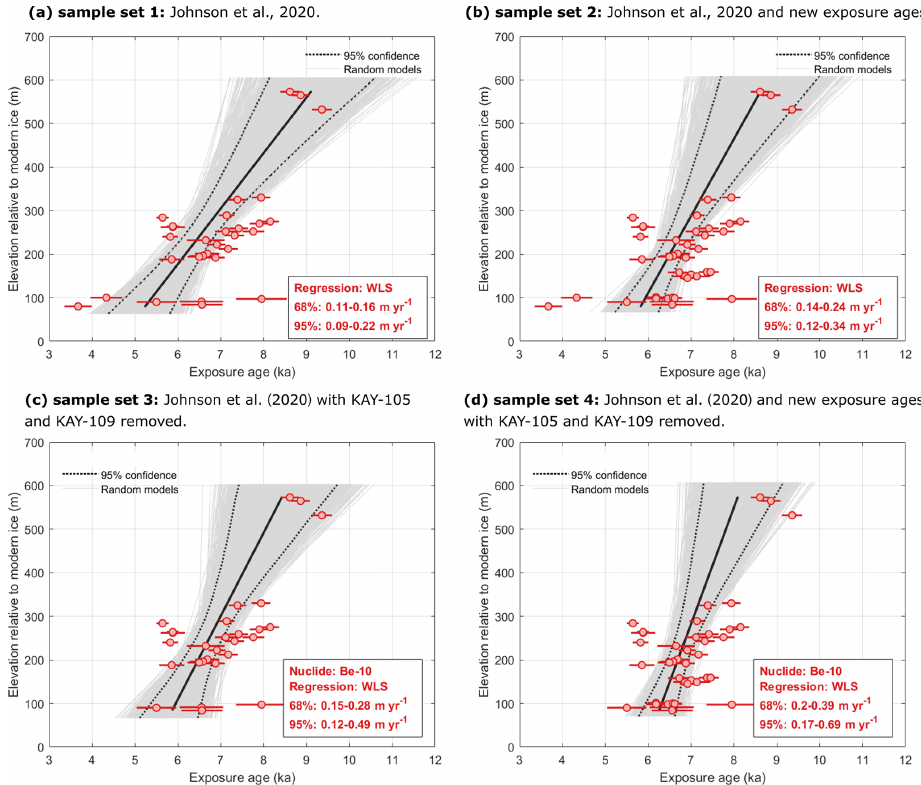
Figure B2. Linear regression models of ice surface thinning generated with iceTEA. Linear regression models showing (a) the original sample set of Johnson et al. (2020), (b) incorporating new data from the scoria cone, (c) removing young ages identified as outliers and (d) incorporating new data from the scoria cone as well as removing young ages identified as outliers. The solid black line is best fit, and grey lines are 5000 Monte Carlo simulations. Dotted black lines represent 95% confidence intervals. Exposure ages displayed as red circles with internal